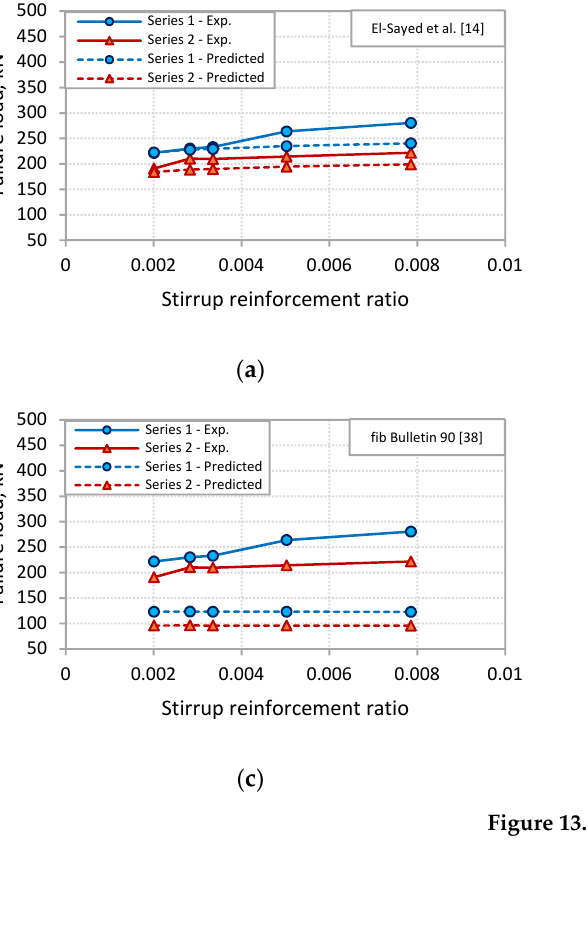
21 of 25 Table 7. Comparisons of fracture energy-based models given by codes for the prediction of plate end debonding capacity of the tested beams.